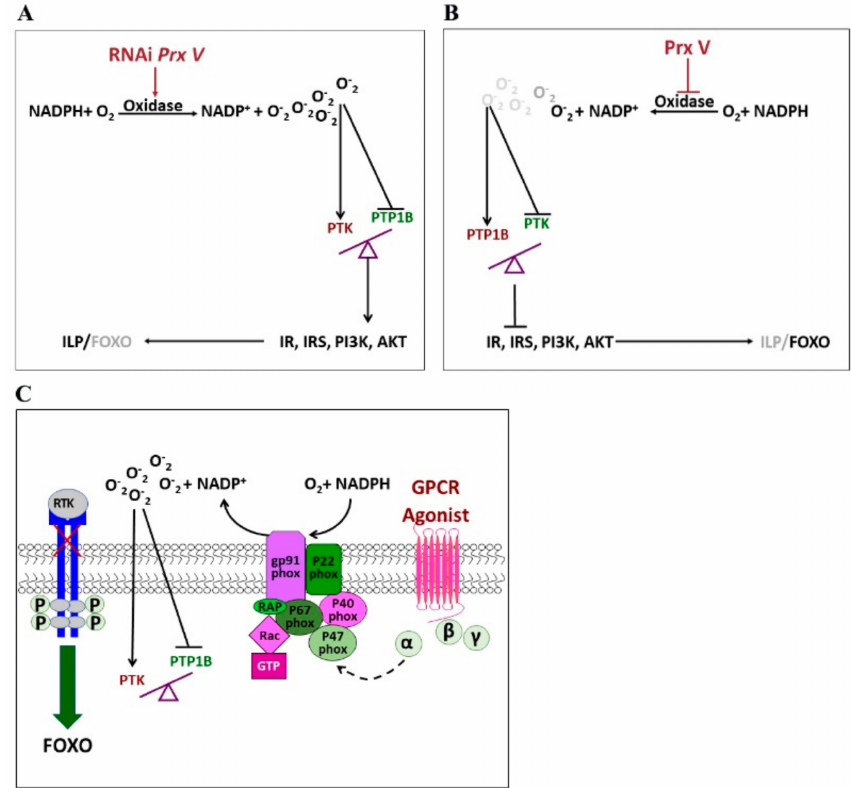
Figure 6. G protein coupled receptor (GPCR) through activation of ROS mediates the balance between PTP1B and PTK, influencing the diapause incidence of migratory locusts through the insulin-like signaling pathway. ( A ) and ( B ) show that antagonism between PTP1B and PTK mediates adults’ insulin-like signal regulating eggs’ diapause of migratory locusts under short photoperiod conditions. Generally, ( A ) RNAi Prx V gene of female adults, will promotes ROS production and NADPH-OX activity, then activates PTK, and increases the relative expression of important genes in the ISP, including IR , IRS , PI3K , and AKT gene under short photoperiod, finally promoting locust development. While ( B ) infection of the Prx V protein to female adults will inhibit ROS production and NADPH-OX activity, then activates PTP1B, and decreases the relative expression of important genes in the ISP, including IR, IRS, PI3K and AKT under short photoperiod, finally induce locust diapause. ( C ) Proposed model: the possible new mechanism wherein GPCR regulation of locust diapause. GPCR agonist (the role contrary with the Prx V) can combine the ligand p47 phox (a ligand of oxidase) to mediates the NADPH oxidation reaction [41], perhaps controlling the balance between PTP1B and PTK in the cell, then induces the PTK expression and increases expression of the IR, IRS , PI3K and AKT gene, also promotes the phosphorylation levels of IR, IRS in the insulin-like signaling pathway and finally promotes the embryo developmental biochemical processes under short photoperiod